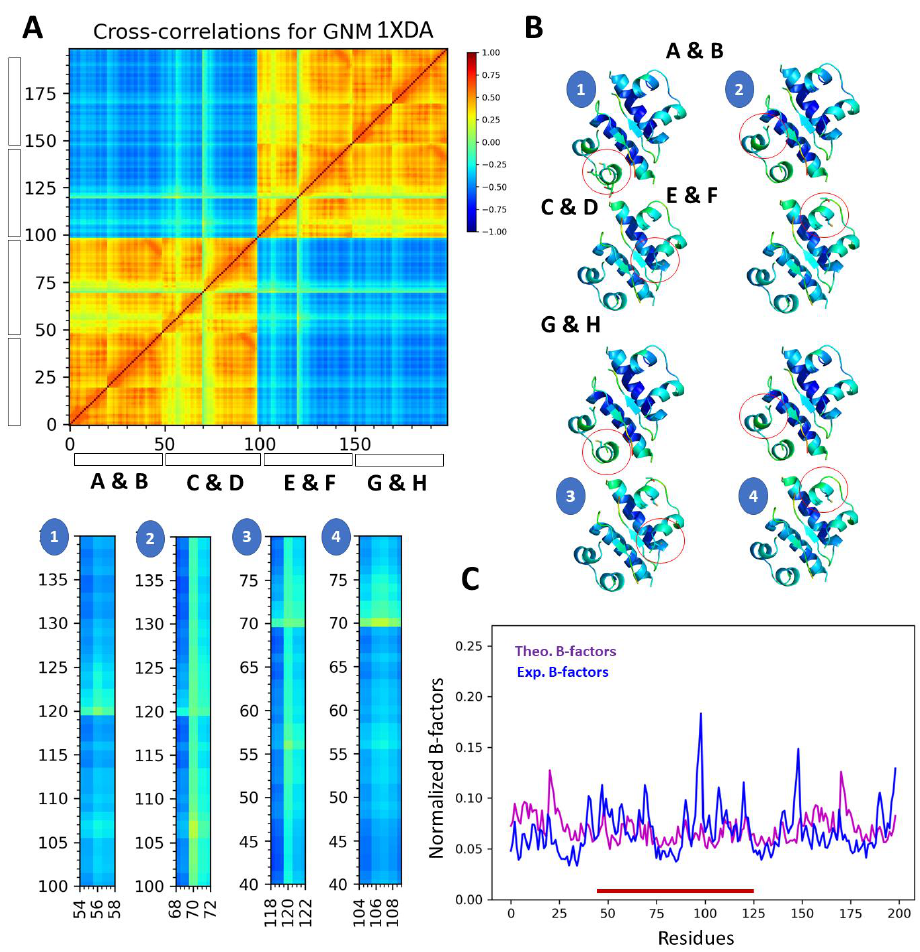
Figure 3. Gaussian Network Model (GNM) analysis results for 1XDA structure. ( A ) Crosscorrelation heat-map from overall GNM modes for 1XDA insulin structure and ~25% correlated critical residues (54–58, 68–72, 104–108, and 118–122, as well as 56, 70, 105–107, and 120). The residue pairs that move in the same direction are colored in red regions (Cijorient > 0); the residue pairs moving in opposite directions are colored in blue regions (Cijorient < 0); uncorrelated pairs are colored in green (Cijorient = 0.0; color-code bar on the right scale). ( B ) The cartoon representation of 1XDA structure is colored in Bfactor. Critical residues, corresponding to the heat map, are numbered and emphasized in red circles. ( C ) Normalized B-factors of 1XDA are colored in blue, and theoretical B-factors calculated by GNM are colored in magenta. Critical residues, corresponding to the heat map, are emphasized in the red line.